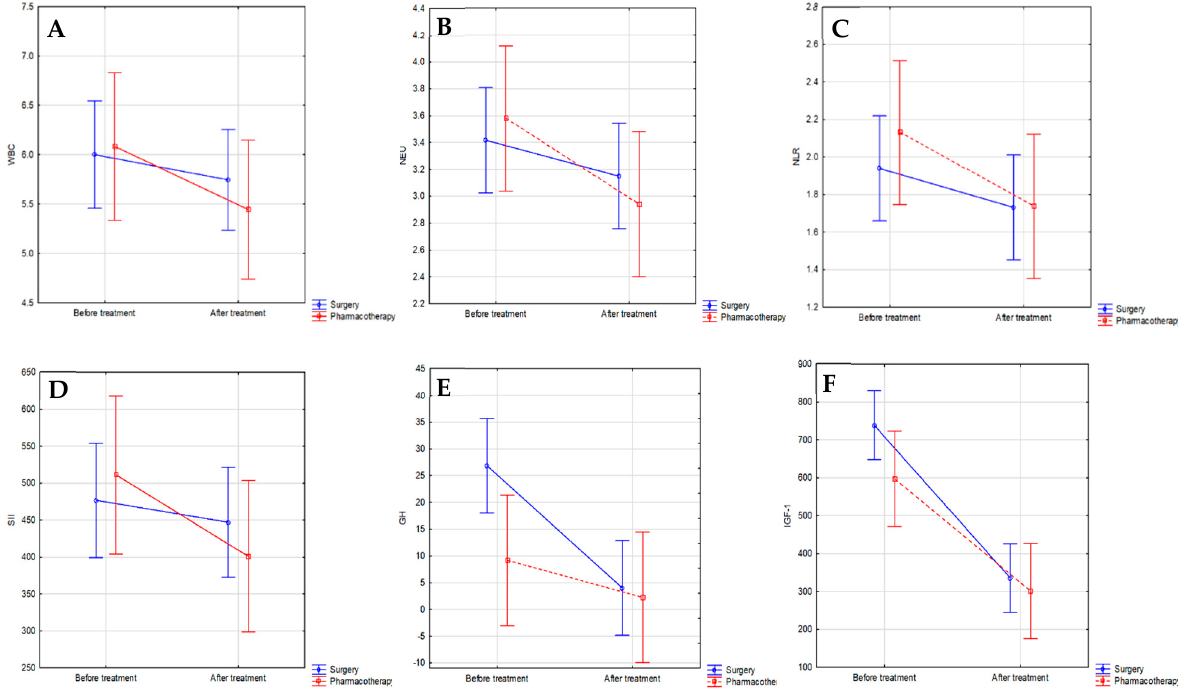
Figure 3. ( A – F ) Analysis using nparLD resulting from the effect of different factors (methods of treatment: pharmacotherapy, surgery; time: before and after therapy) on blood count parameters. ( A ) The interaction effect of the time ( p = 0.022). WBC before: surgery 5.67 (IQR 4.80–7.15), pharmacotherapy 5.98 (IQR 4.79–6.84); WBC after: surgery 5.56